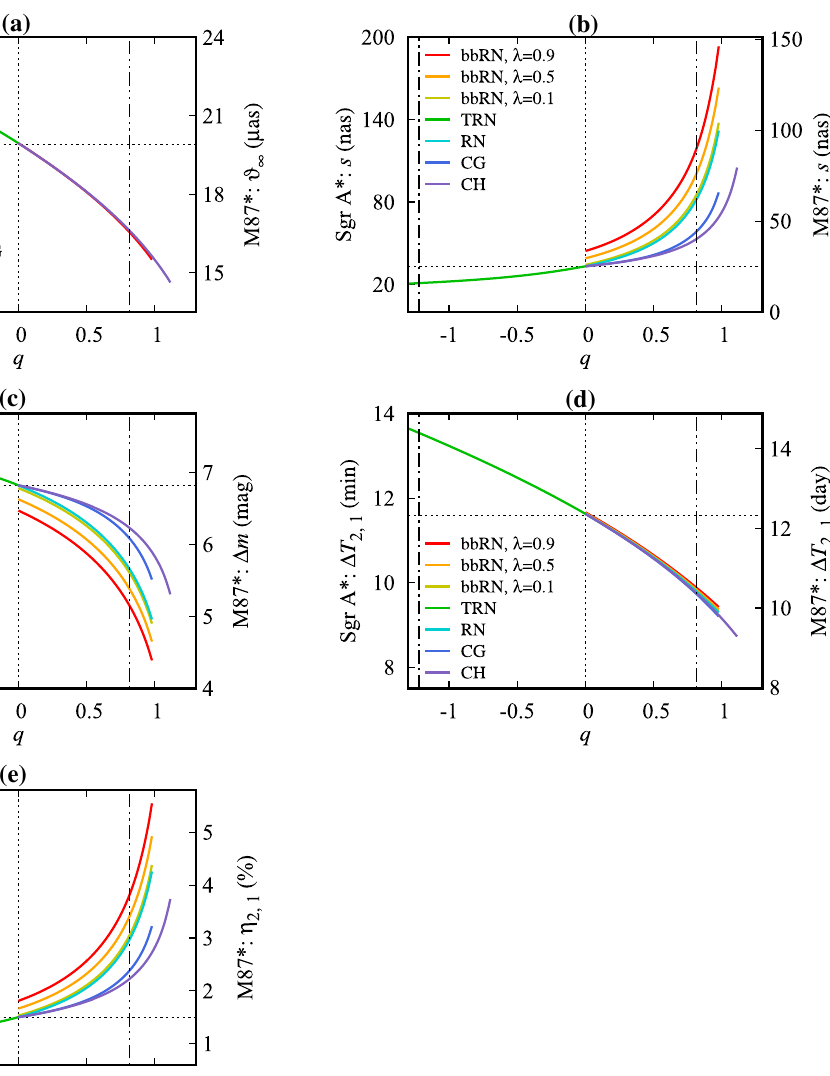
Fig. 10 Comparisons of the observables in the strong deflection gravi- tational lensing for Sgr A* (left y -axes) and M87* (right y -axes) by the black-bounce-Reissner–Nordström spacetime (bbRN), the Reissner– Nordström black hole (RN), the tidal Reissner–Nordström black hole (TRN),thechargedHorndeskiblackhole(CH)andthechargedGalileon